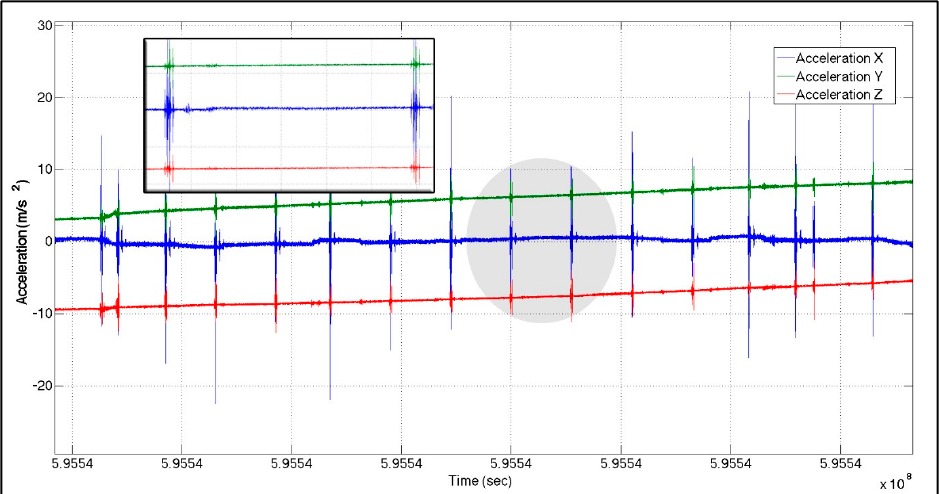
Figure 4. Accelerometer output—MEMS (SiIMU02).